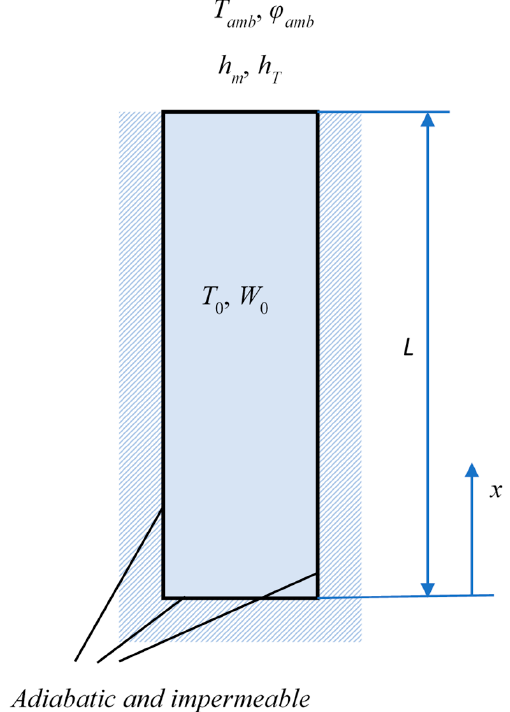
Figure 1. Schematic of the brick with boundary and initial conditions considered in numerical simulations.